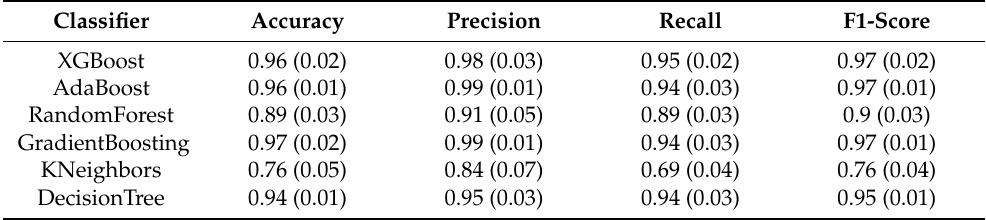
Table 6. Models’ performance for Gaussian Spreading with only small packets (standard deviation in